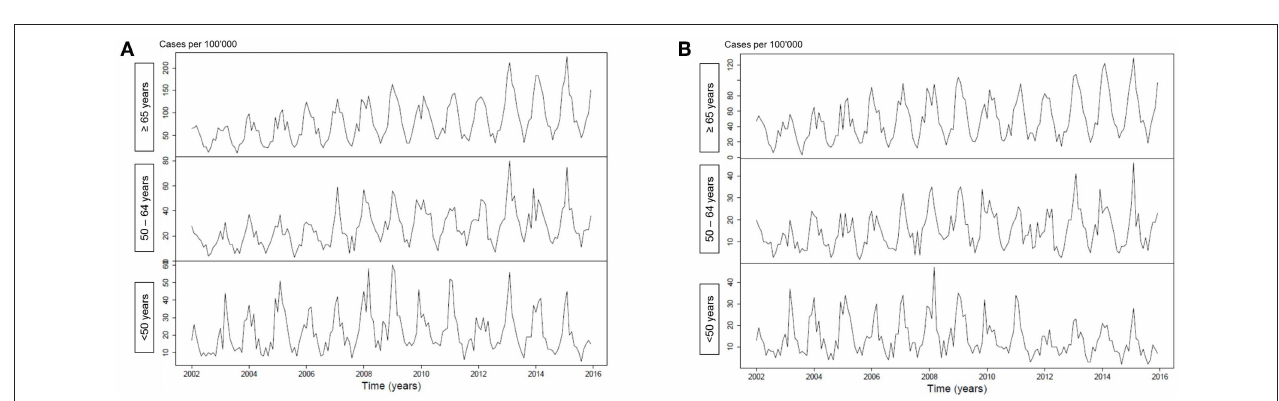
FIGURE 2 | (A) Incidence of pneumococcal pneumonia hospitalization (any diagnosis) over time, stratified for age groups. (B) Incidence of pneumococcal pneumonia hospitalization (primary diagnosis) over time, stratified for age groups.